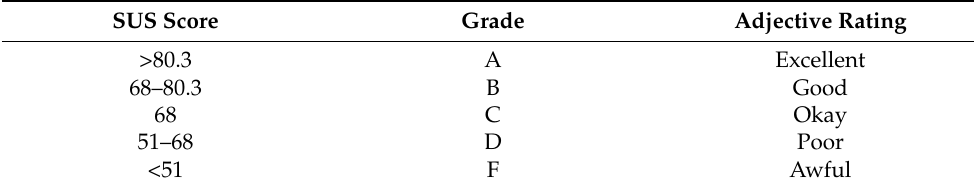
Table 12. SUS score rating guideline.